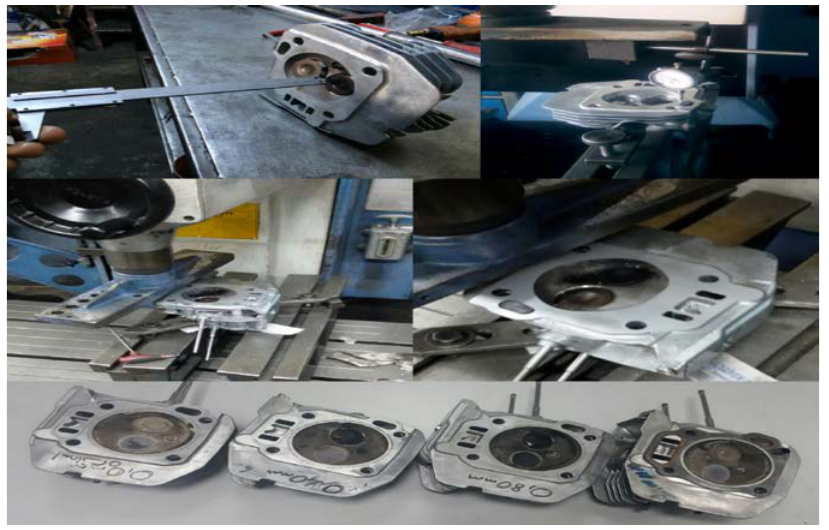
Figure 3. Grinding of cylinder head.